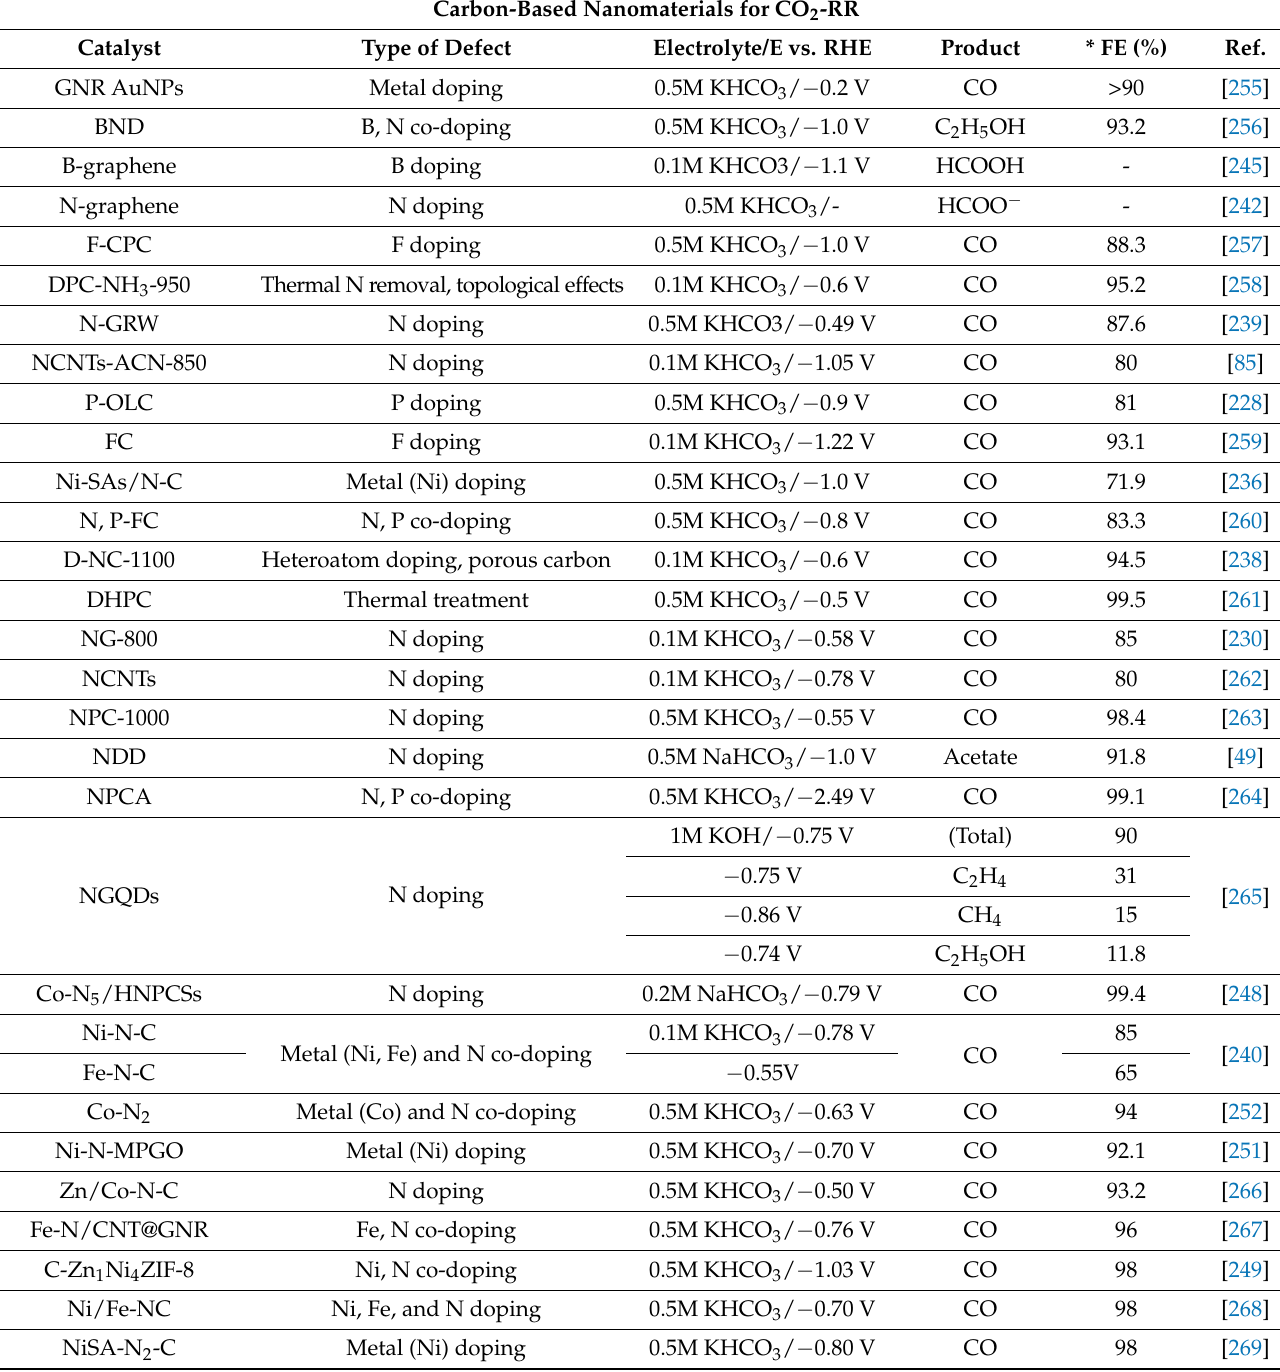
Table 5. Carbon-based electrocatalysts for electrochemical CO 2 -RR. Carbon-Based Nanomaterials for CO 2